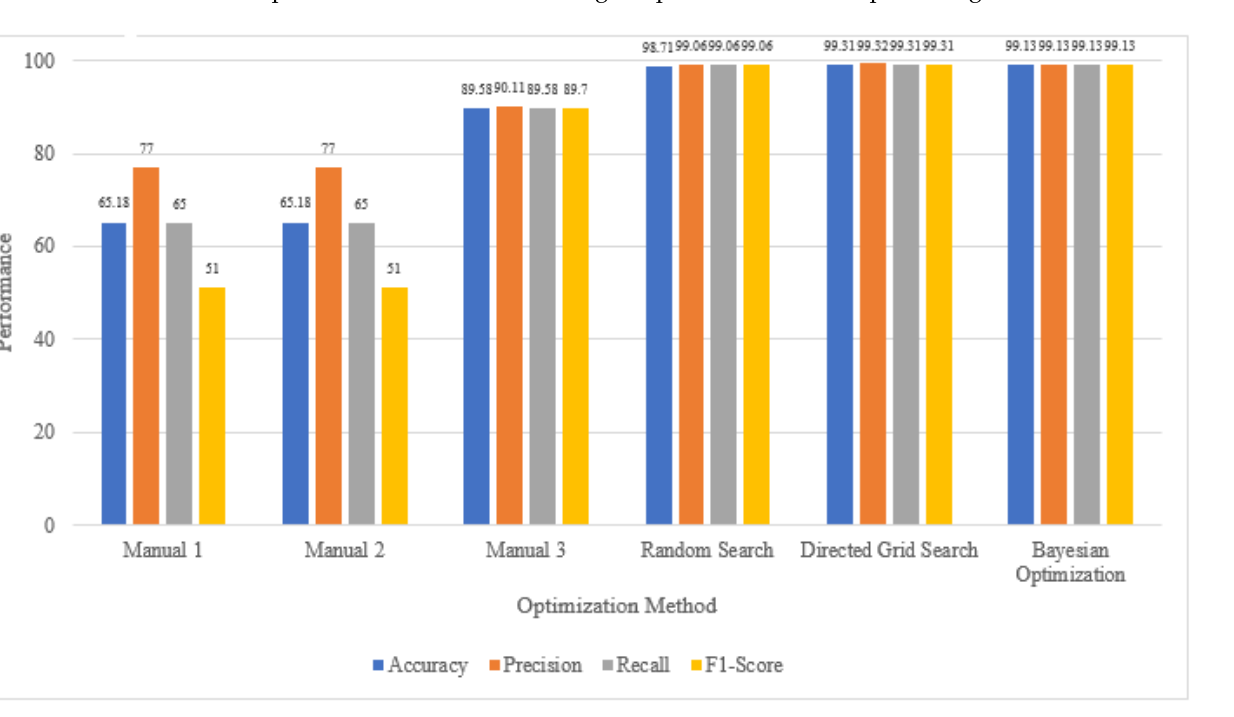
Table Legend: H T : HPO Technique, A: Aspect, T T : Type of Technique, H S : Hypercube or Search Space Size, N I : Number of Iterations, T T : Training Time, A T : Average Time Per Hyper-parameter Evaluation, GS Case 1: Considering the average time of RS, GS Case 2: Considering the average time of DGS.